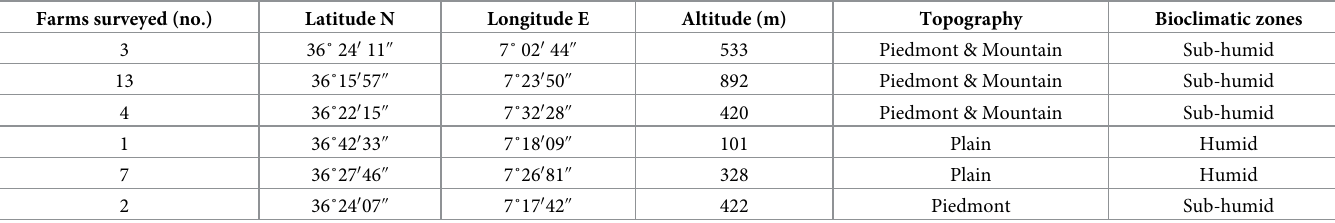
Table 1. General characteristic of the study locations and number of cattle herds surveyed in Guelma region (Algeria). Farms surveyed